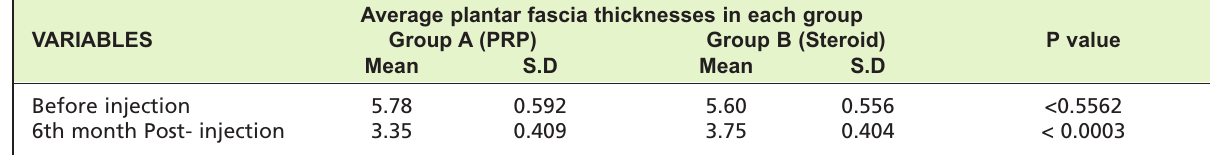
Thickness of plantar fascia before treatment and at 6 months after Table IV: